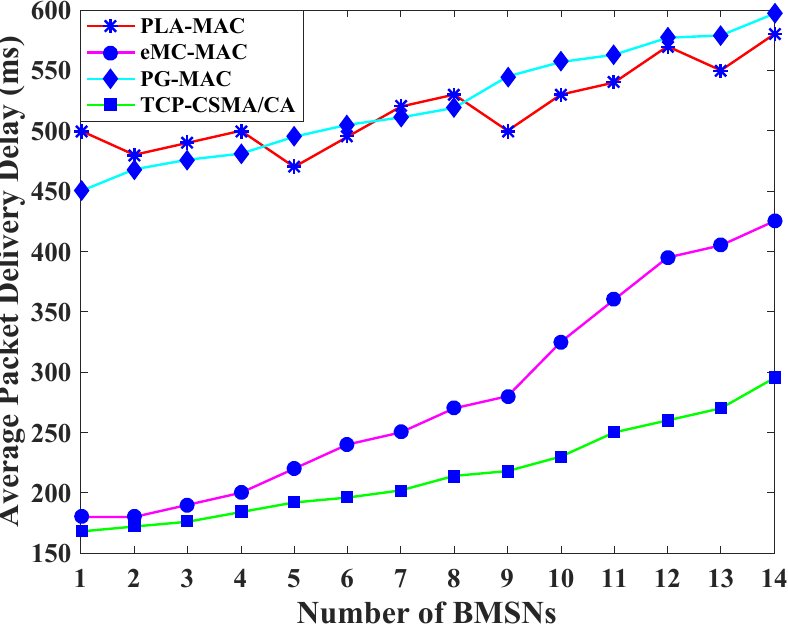
Figure 2. Average packet delivery delay versus number of BMSNs.